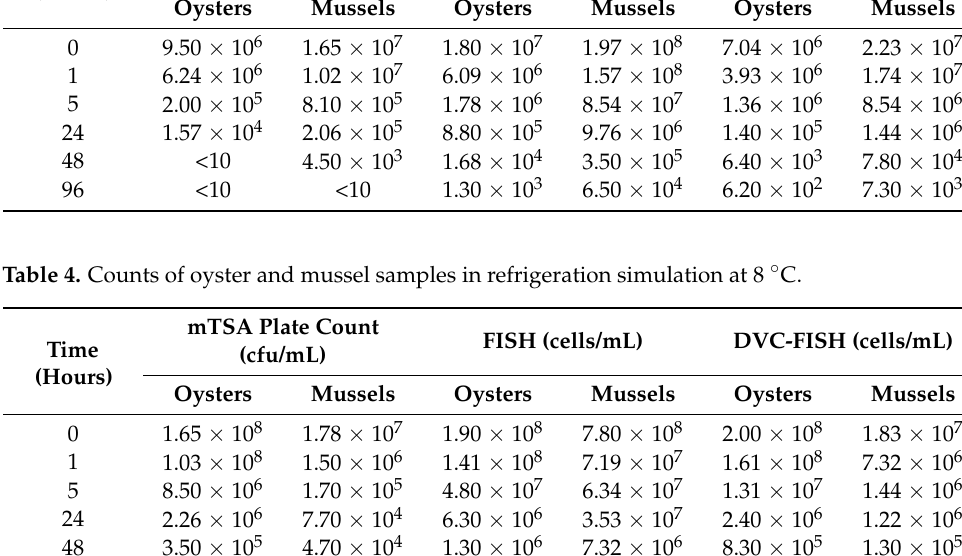
Table 3. Counts of oyster and mussel samples in refrigeration simulation at 4 ◦ C. Time